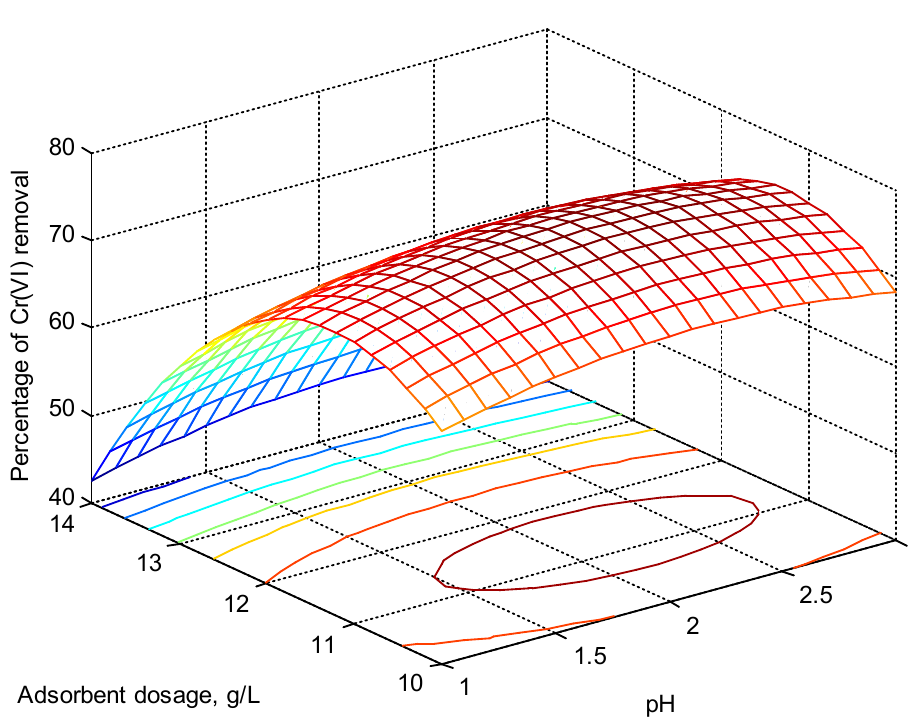
Figure 6. Effect of interaction between mixed adsorbent dosage and pH on removal of Cr (VI) (initial concentration at 20.02